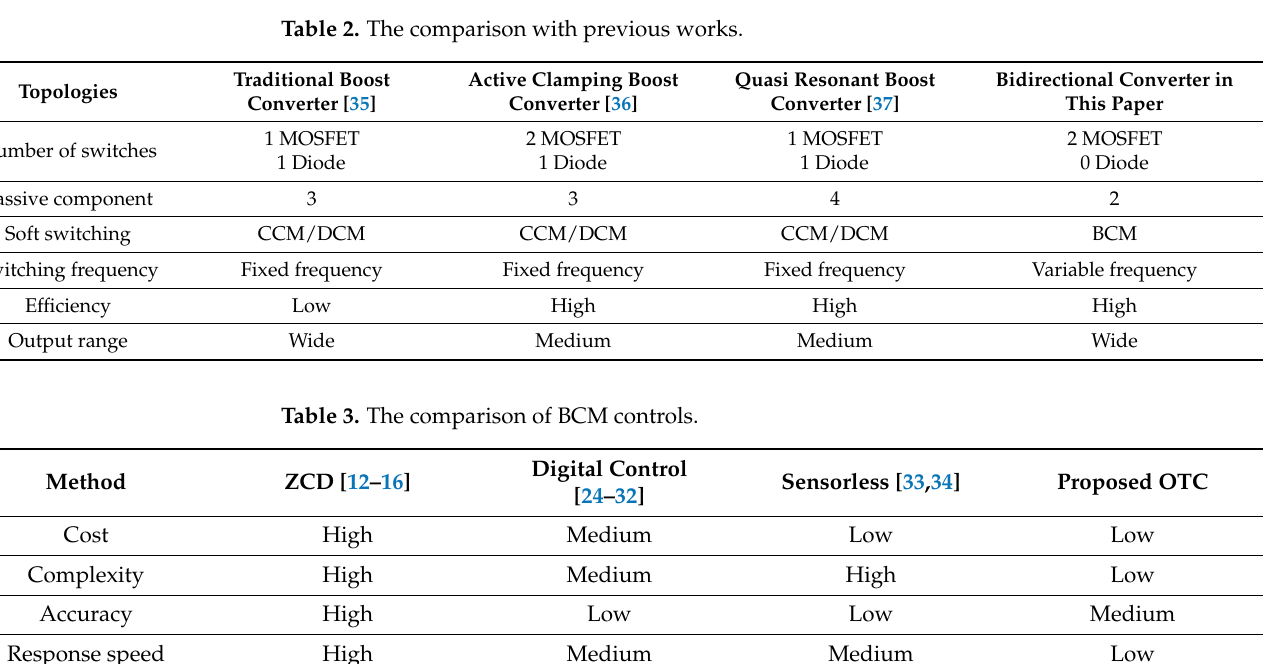
Table 2. The comparison with previous works.